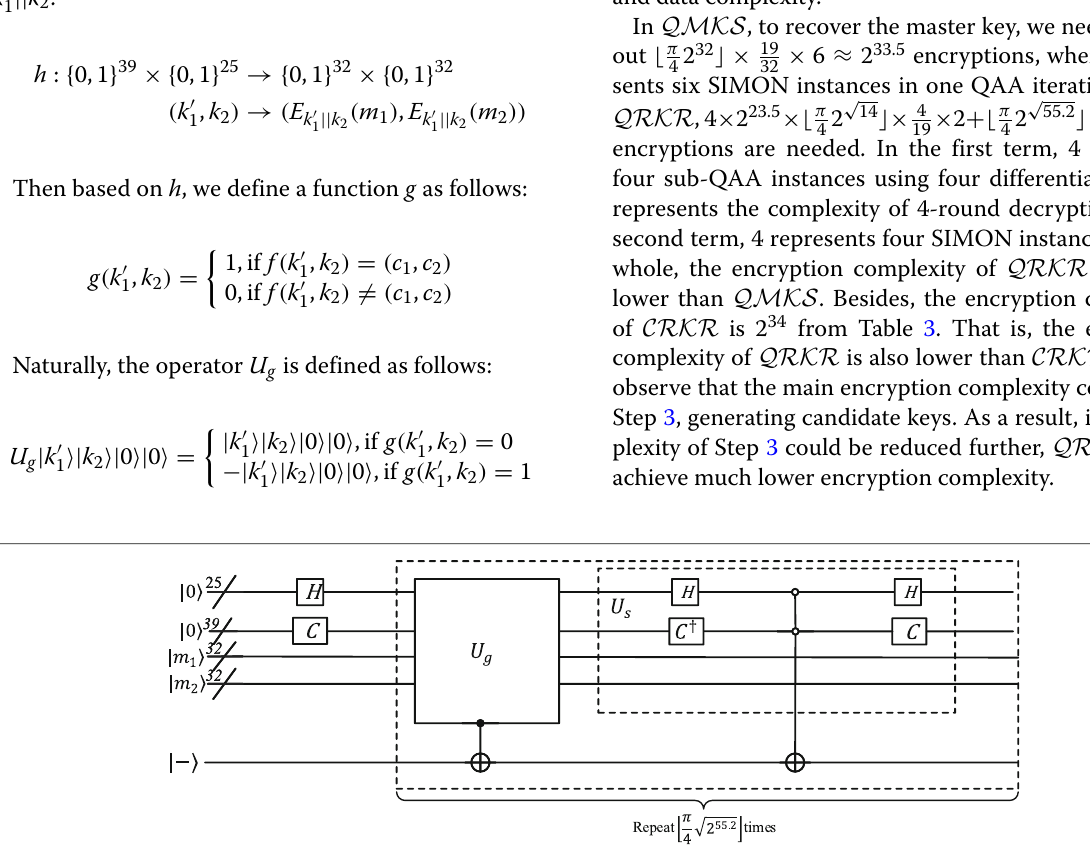
Fig. 10 The quantum circuit of exhaustive search in